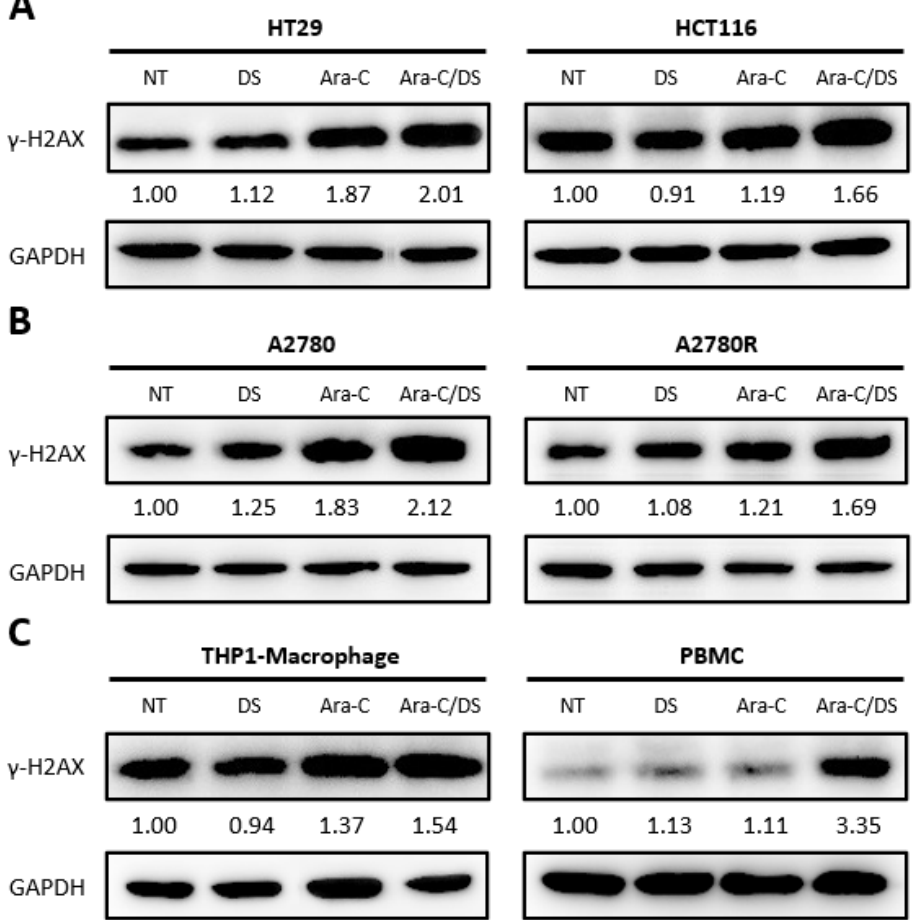
Figure 3. Assessment of DNA damage induction by Ara-C/DS and its components. Presented are immunoblots of histone γ -H2AX and GAPDH in ( A ) colorectal cells cell lines (HT-29 & HCT 116), ( B ) ovarian cancer cell lines (A2780 & A2780R), and ( C ) immunological cells (THP-1 derived macrophages & PBMC) after treatment for 24 h with Ara-C (50 nM), the DS (1 µg/mL), or their combination (Ara-C/DS). Results shown are representative of three replicate experiments. NT = non-treated. Densitometry values have been normalized to the GAPDH loading control, and are relative to the NT control. The uncropped bolts are shown in Supplementary Materials.